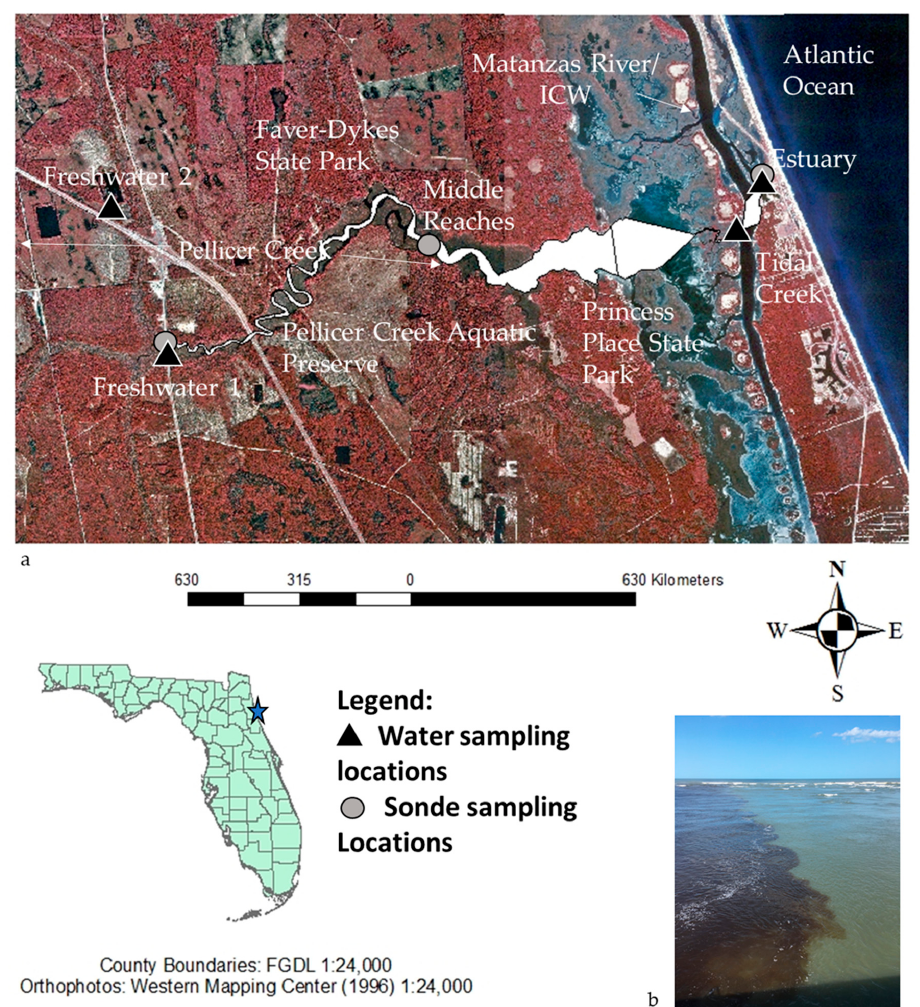
Figure 1. The three locations where YSI data sondes were placed along the study site located in St. Augustine, FL (grey circles). ( a ) Map was created using ArcGIS 10.5 software (ESRI). Coordinate System: GCS WGS 1984. The baselayer was created from orthophotos from the Western Mapping Center. Estuary location is location within the Intracoastal Estuary, middle reaches is in Pellicer Creek blackwater river that impacts from daily tidal cycles, and freshwater 1 is located near the headwaters of Pellicer Creek where salinity drops to 0 psu. Water samples for longer-term sampling were collected at the estuary, tidal creek, freshwater 1, and freshwater 2 sites (black triangles). The span of the study site from the estuary to freshwater 2 is approximately 15 km in length when following the waterway. The nearest inlet between the estuary and the Atlantic Ocean is approximately 4.5 km south. ( b ) The nearest inlet between the estuary and the Atlantic Ocean (bottom right) is approximately 4.5 km